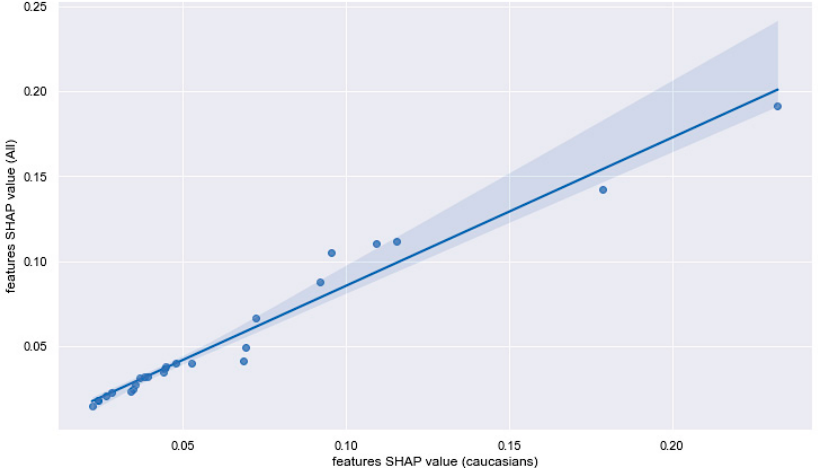
Figure 7. Scatter plot for the top 20 features from the model (for input a and b, excluding genetics) using SHAP. Each dot in the plot represents the feature value for a variable for the Caucasians and the mixed ethnicity populations. The shaded area marks the 95% confidence interval.